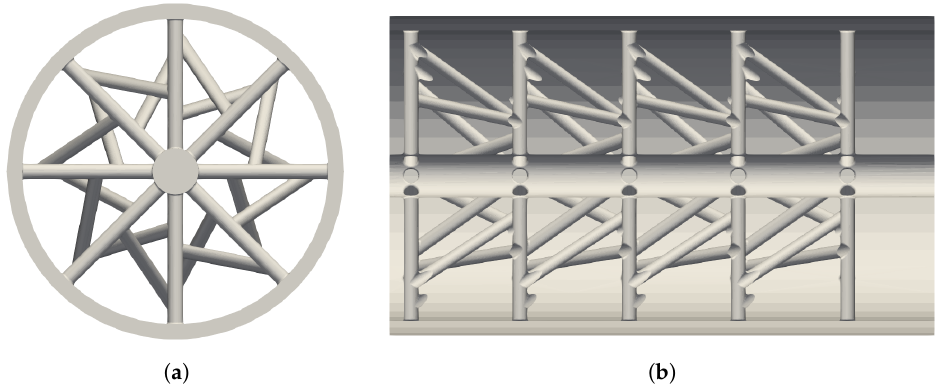
Figure 2. POCS geometrical characterization: Straight configuration: ( a ) Frontal section; and ( b ) Longitudinal clip.